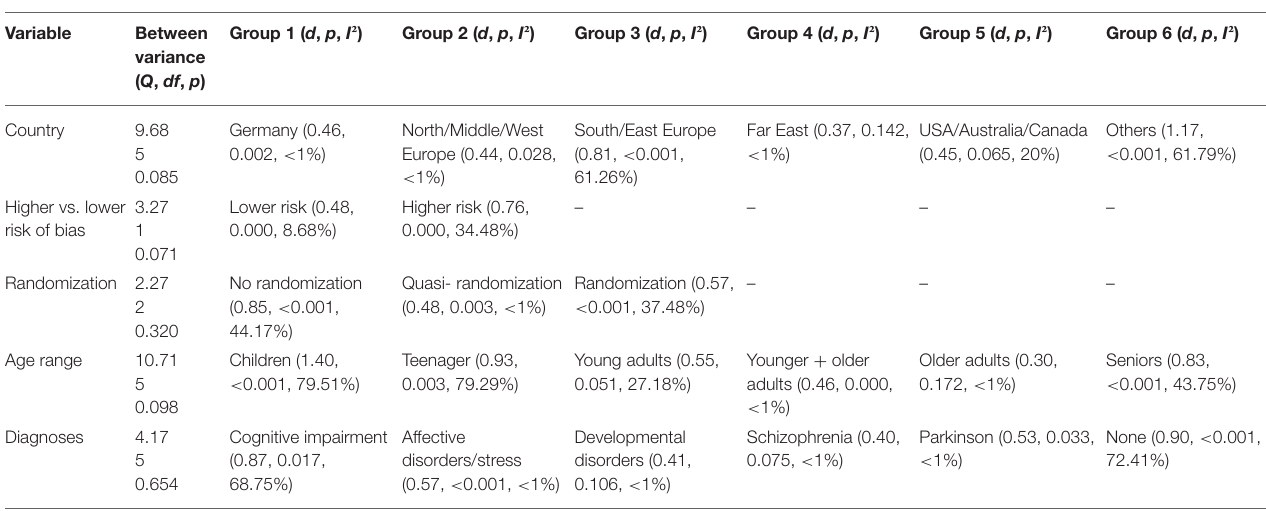
TABLE 5 | Categorical